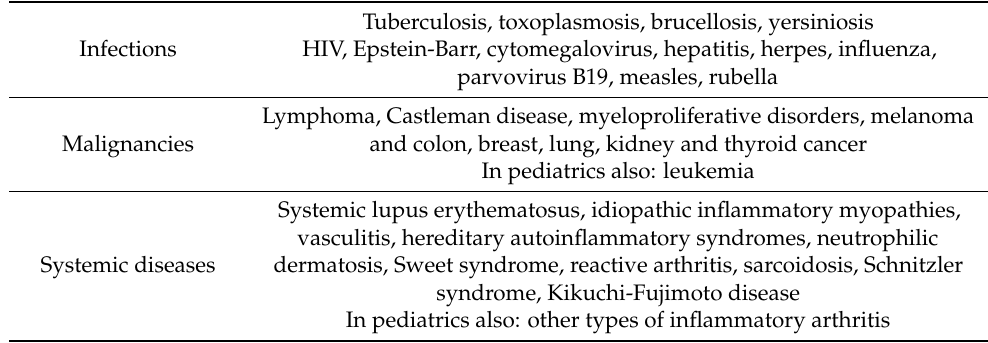
Table 1. Differential diagnosis of AoSD